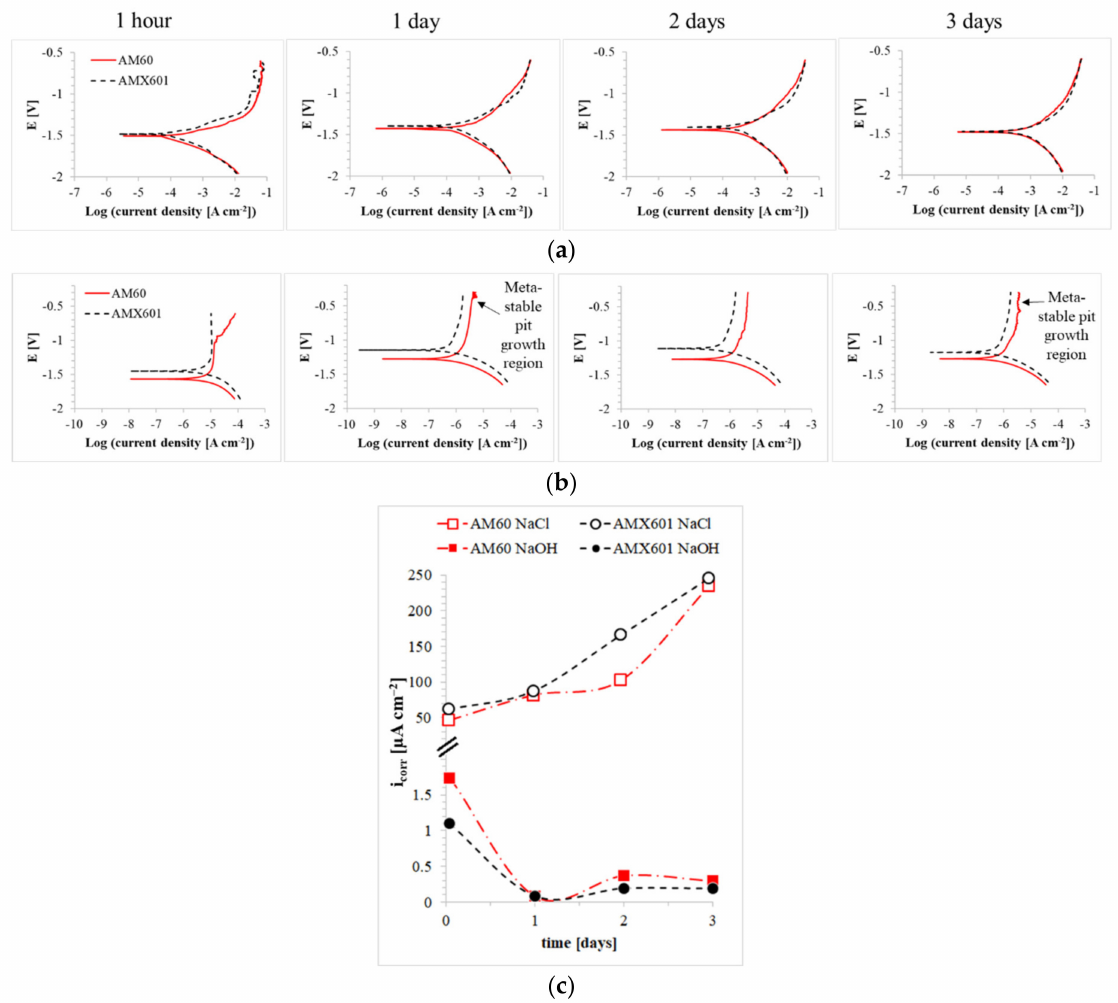
Figure 10. Potentiodynamic polarization curves of AM60 and AMX601 alloys after different immersion periods in: ( a ) 3.5 wt% NaCl solution saturated with Mg (OH) 2 ; ( b ) NaOH solution (pH ≈ 10.5); ( c ) the calculated corrosion current density of AM60 and AMX601 alloys as a function of time in different